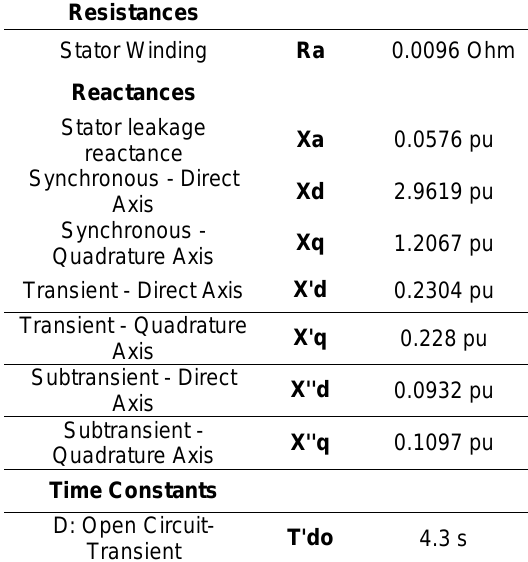
Table 3. Diesel generator parameters (B)